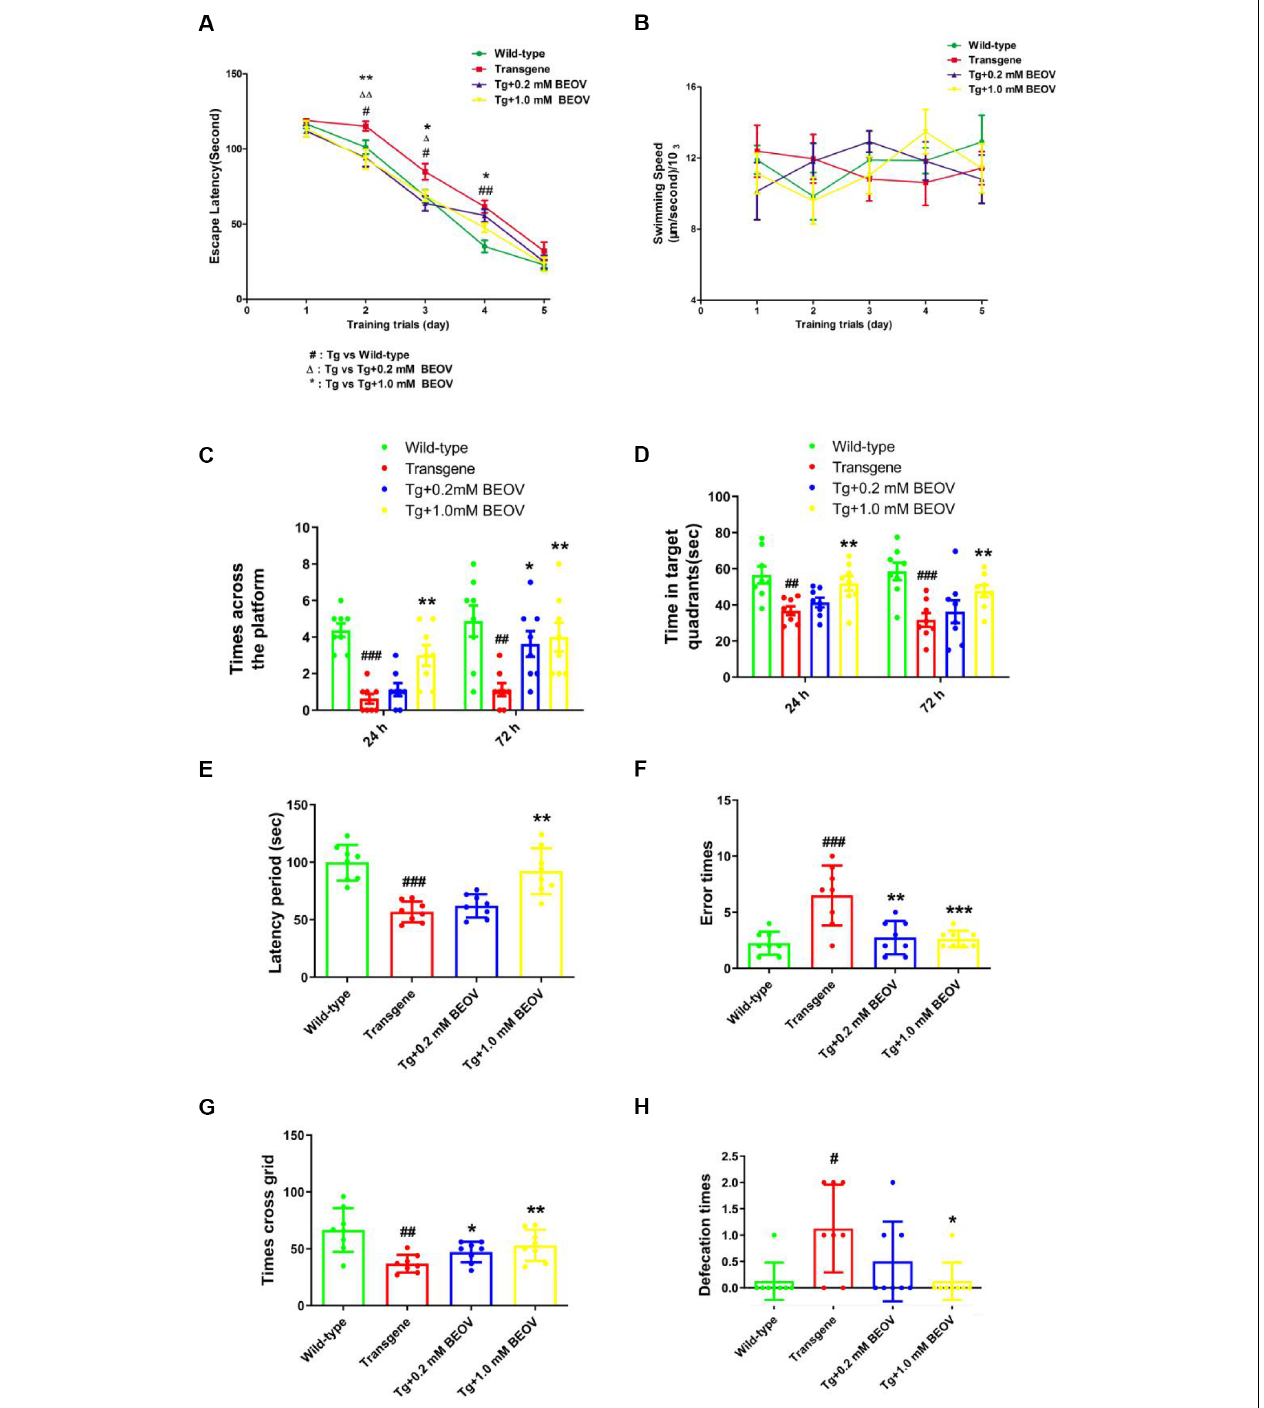
FIGURE 1 | Bis(ethylmaltolato) oxidovanadium (IV) (BEOV) treatment ameliorated learning and memory deficits in APPSwe/PS1dE9 mice. (A–D) The Morris water maze (MWM) test was used to assess contextual memory in mice. (A,B) During the 5 days of spatial orientation trials, escape latency and swimming speed were measured to evaluate the memory and locomotor ability of the WT, APPSwe/PS1dE9, and BEOV-treated APPSwe/PS1dE9 mice, respectively. (C,D) For the 24-h and 72-h probe trials, the number of crossing over the original platform area and the time spent in the target quadrants were recorded. (E,F) The learning and memory impairments in APPSwe/PS1dE9 mice were evaluated by step-down avoidance test. (G,H) Depression and anxiety-related behavior in APPSwe/PS1dE9 mice were evaluated by open-field test. # WT group vs. Alzheimer’s disease (AD) group; *AD + BEOV group vs. AD group. n = 8, four females and four males; # P < 0.05, ## P < 0.01, ### P < 0.001, * P < 0.05, ** P < 0.01, and *** P < 0.001, respectively.